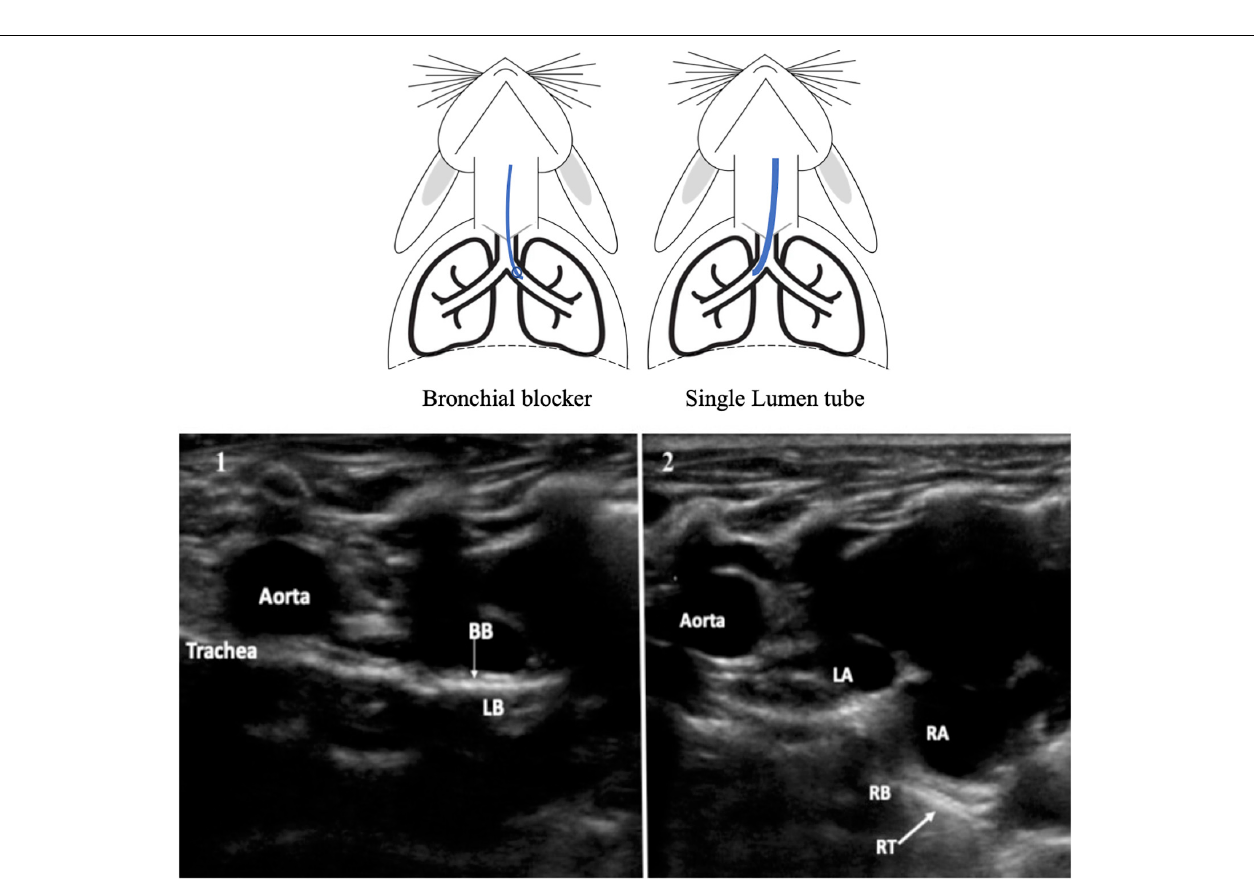
FIGURE 6 | Oblique, parasternal, and midclavicular plane 1. Bronchial blocker in the left bronchus. BB, Bronchial blocker, LB, Left bronchus. 2. Reinforced tube in the right bronchus. RT, Reinforced tube, RB, Right Bronchus, LA, left atrium, RA, right atrium.